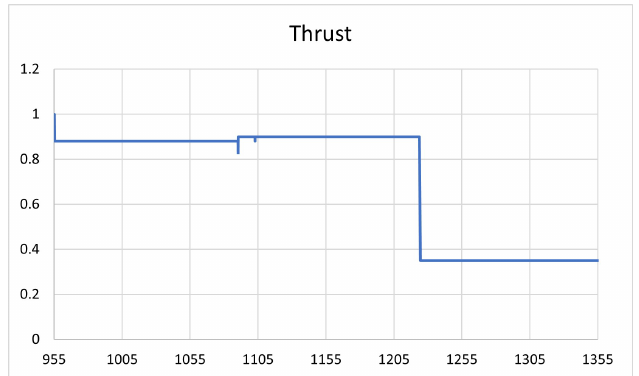
Figure 5. Thrust: Validation